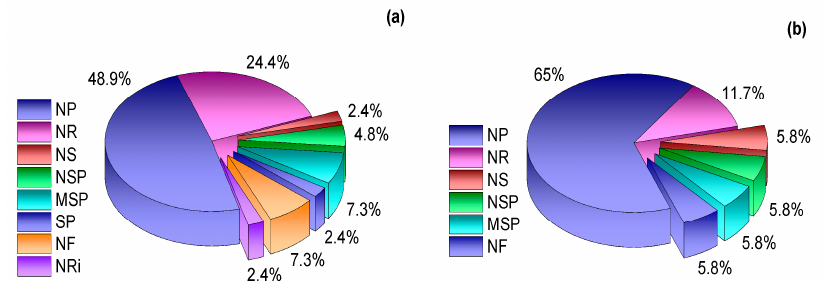
Figure 26. Percentage distribution of the reported ZnO morphologies in the publications related to ZnO–graphene composites applied to photocatalysis. ( a ) Using UV light, ( b ) using visible light . NP = nanoparticle, NR = nanorod, NS = nanosheet, NSP = nanosphere, MSP = microsphere, SP = sphere, NF = nanoflower, NRi = nanoring.